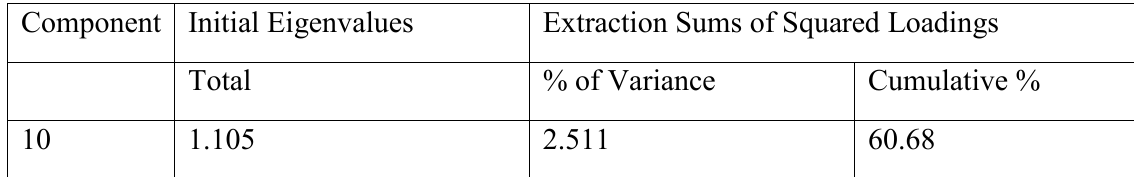
Table 1.19: Variance explained for Absorptive Resilience PC10